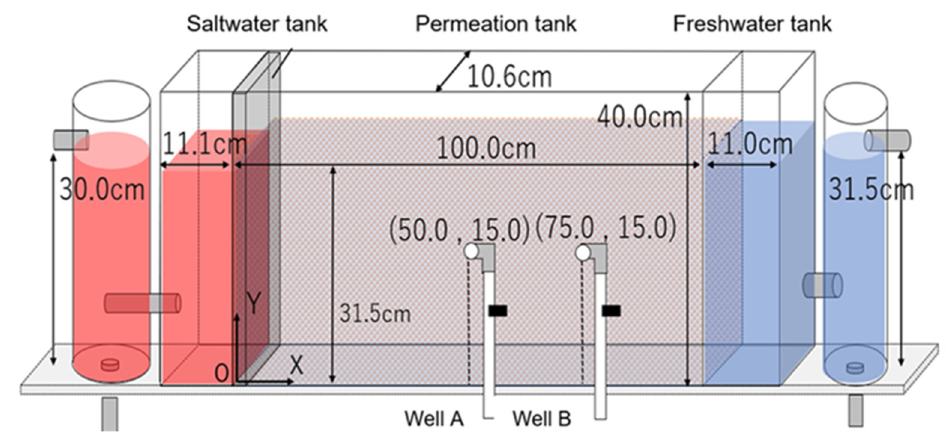
Figure 2. Conceptual diagram of the experimental device. (Well A is a barrier well and Well B is a production well.)